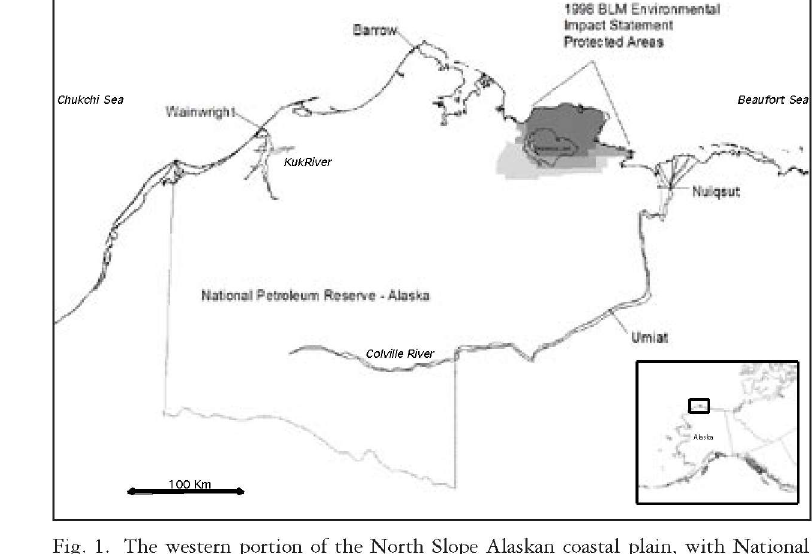
Fig. 1. The western portion of the North Slope Alaskan coastal plain, with National Petroleum Reserve — Alaska boundary in dashed line. Three stipulation areas from the 1998 Bureau of Land Management Final Integrated Activity Plan/ Environmental Impact Statement (EIS) are shaded. From north to south, they are termed "no leasing," "no surface activity," and "special caribou stipulations." Collectively, we have termed this area the "protective boundary," which was used for further